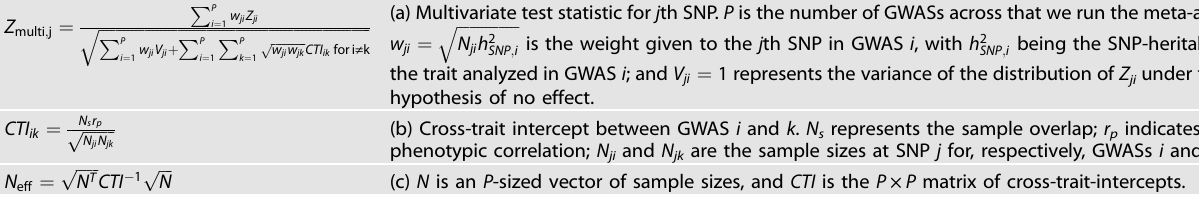
Table 1. (a) Multivariate test statistic in the meta-analysis of results based on overlapping samples; (b) expected value for the cross-trait-intercept; (c) effective sample size for a GWAMA. Z multi ; j